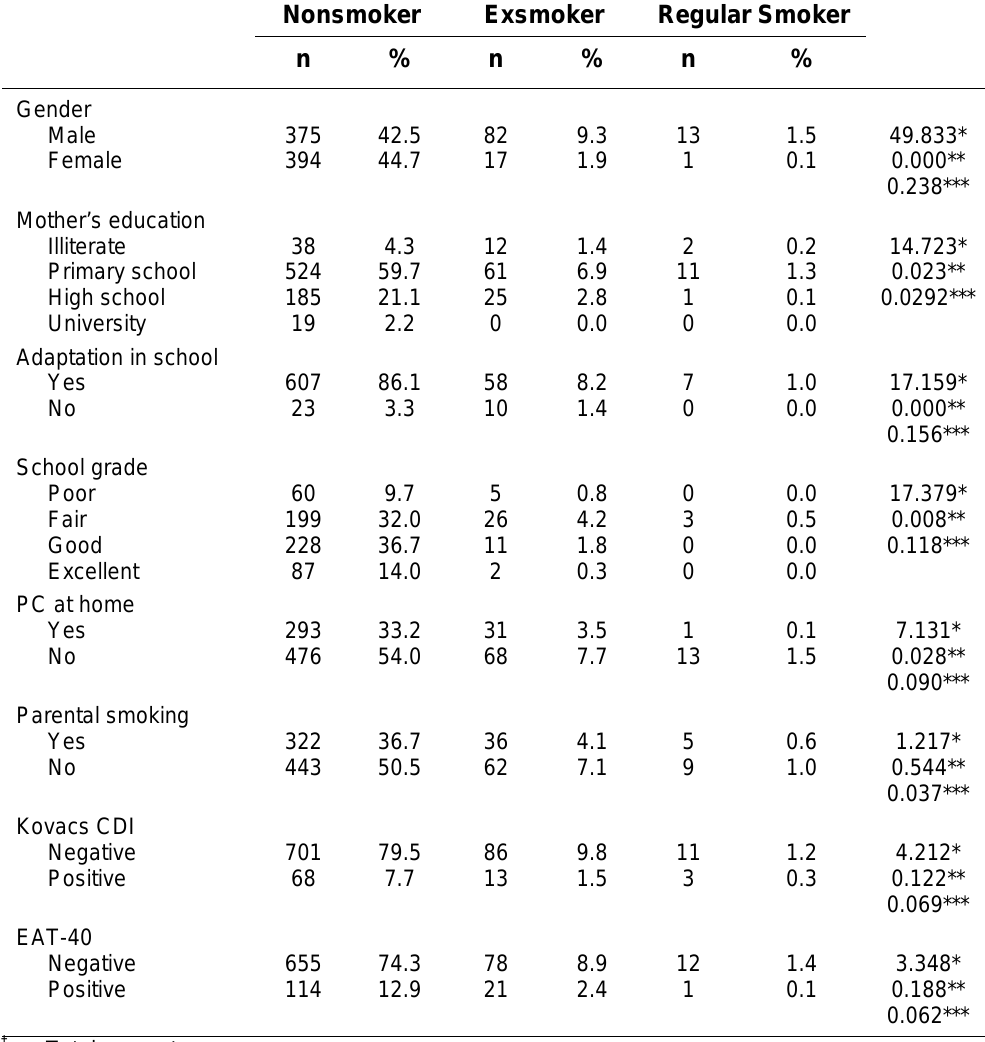
Distribution of Study Group According to Smoking